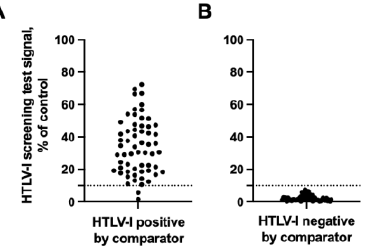
Figure 2. Image analysis of the rapid screening test for HTLV-I. The HTLV p24-specific IgG signal from the rapid screening test was determined and plotted as a % of control for individuals who tested ( A ) positive or ( B ) negative by the comparator test. The y-axis corresponds to the background subtracted IgG signal normalized to the control for each test. Dashed line, cutoff. Table 2. Performance statistics of Rapid Screening Test for HTLV-I.